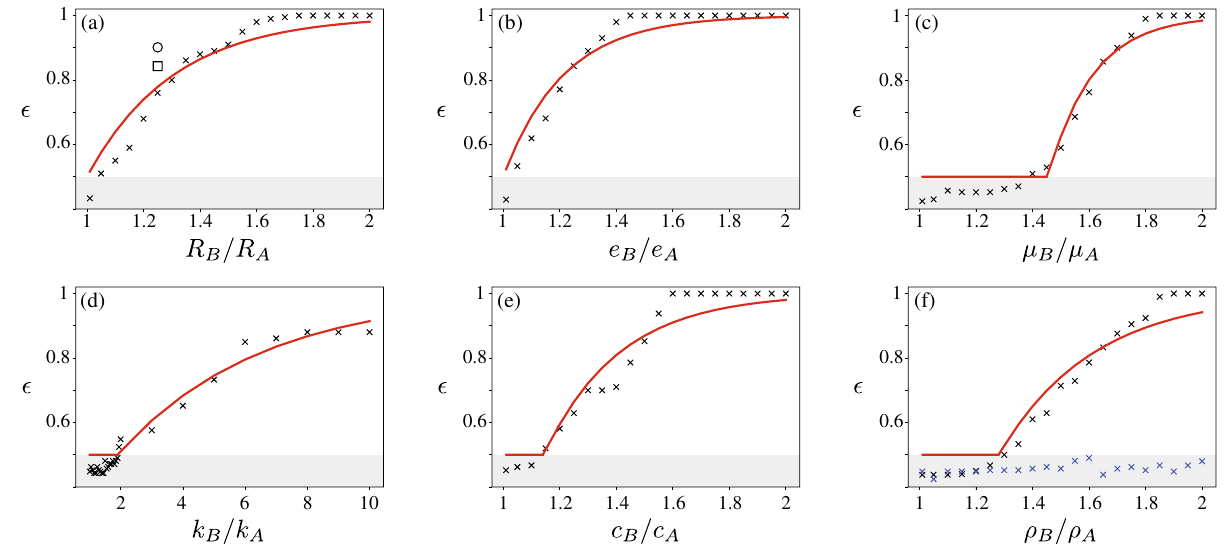
Figure 2. Prediction accuracy ǫ for grain types with differing properties. ( a ) radius, ( b ) coefficient of restitution, ( c ) coefficient of friction, ( d ) stiffness ( e ) cohesion and ( f ) density without (blue) and with (black) a background 3 drag force (fluid viscosity η = 10 − Pa s). Each symbol represents the ANN prediction obtained by training and testing against 200 trajectories of two grain types. Properties of grain type A are summarised in Table 1. Grains of type B differ by one properties ( × ), or two properties including coefficient of restitution e B = 1.25 e A ( ◦ ) or coefficient of friction µ B = 1.35 µ A ( (cid:31) ). Red lines correspond to best fits of the accuracy using Eqs. (1) or (2). Grey areas denote accuracy lower than that of a random classification ( ǫ = 0.5